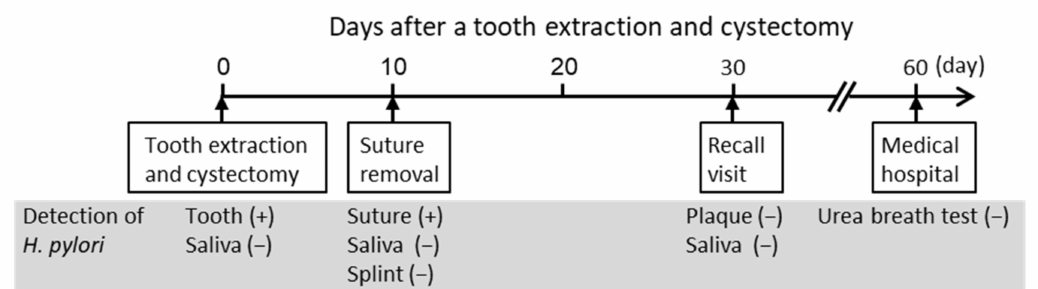
Figure 5. Timeline of the present case after tooth extraction and